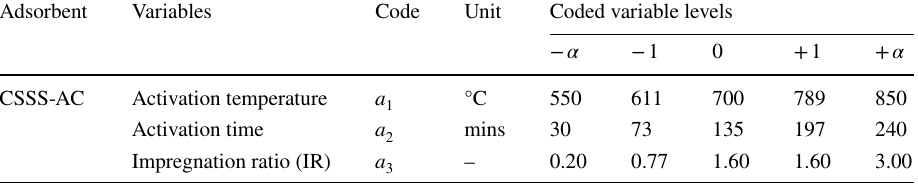
Table 2 Independent variables and their coded levels for the central composite design of Canarium schweinfurthii seed shells activated carbon (CSSS-AC)